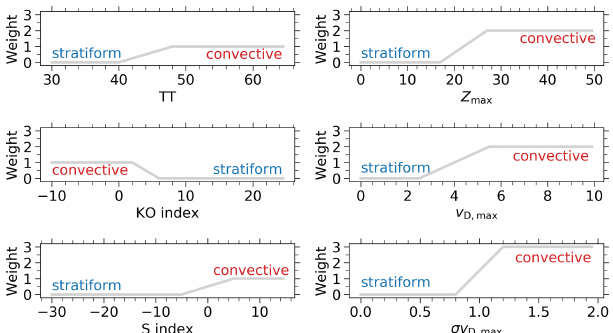
Figure 1. Weight of the meteorological and radar-based convec- tion criteria: total totals (TT), convection index (KO), soaring index ( S ), maximum of the reflectivity ( Z max ) per profile, maximum of the Doppler velocity ( v D , max ) per profile and the maximum (per profile) of the temporal standard deviation of the Doppler velocity ( σv D , max ) within a ± 15min interval.